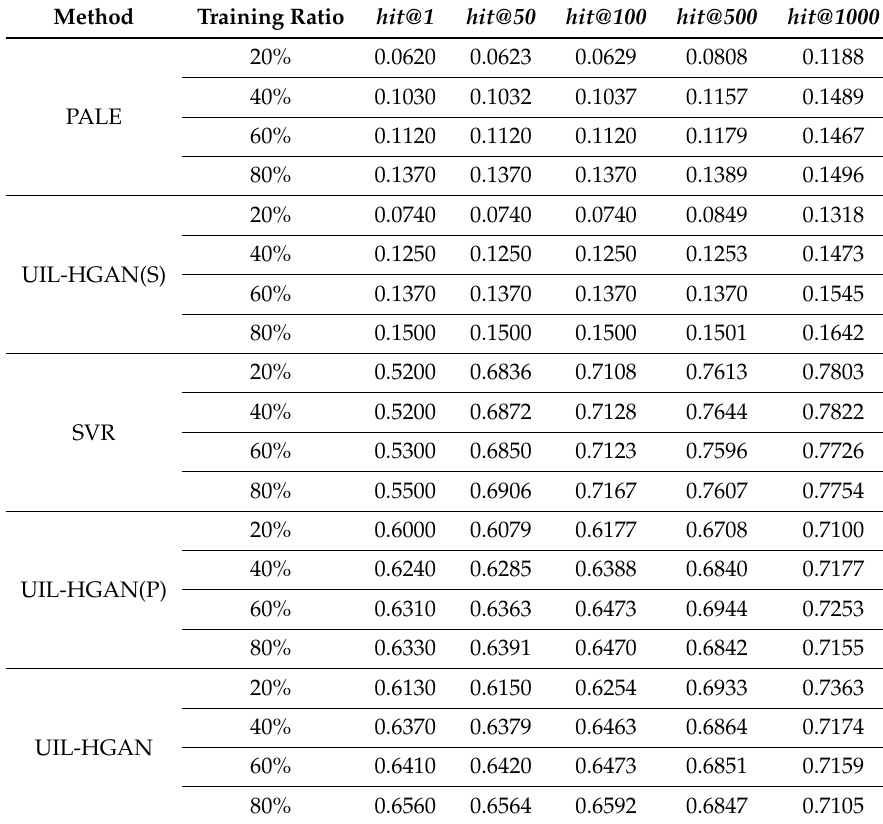
Figure 6. hit@1 precisions of different methods on the Facebook-Twitter dataset. Table 2. Performance of different methods on the Facebook-Twitter